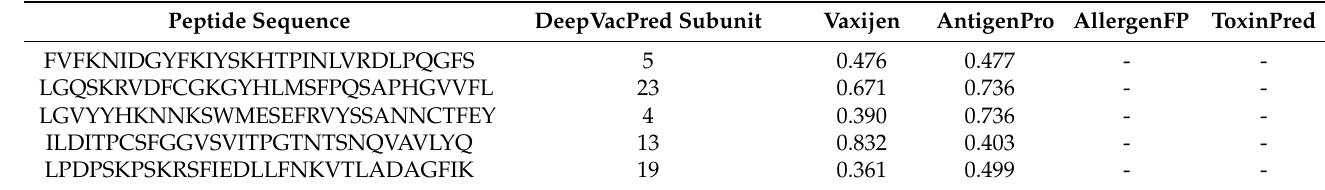
with allergenicity, antigenicity, and toxicity filters. AllergenFP did not predict allergenicity values, and ToxinPred did not predict toxicity values for any sequences. This is evidence of the top epitopes not exhibiting significant levels of allergenicity or toxicity. IntegralVac’s results matched precisely with the DeepVacPred server’s predictions using the same checkpoint filter prediction servers